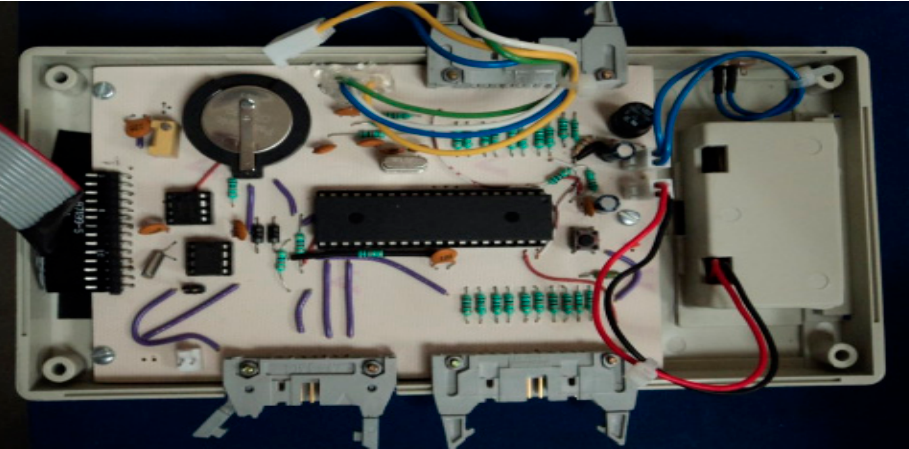
Figure 5. Electronic view of portable system for monitoring the microclimate in the footwear-foot interface.